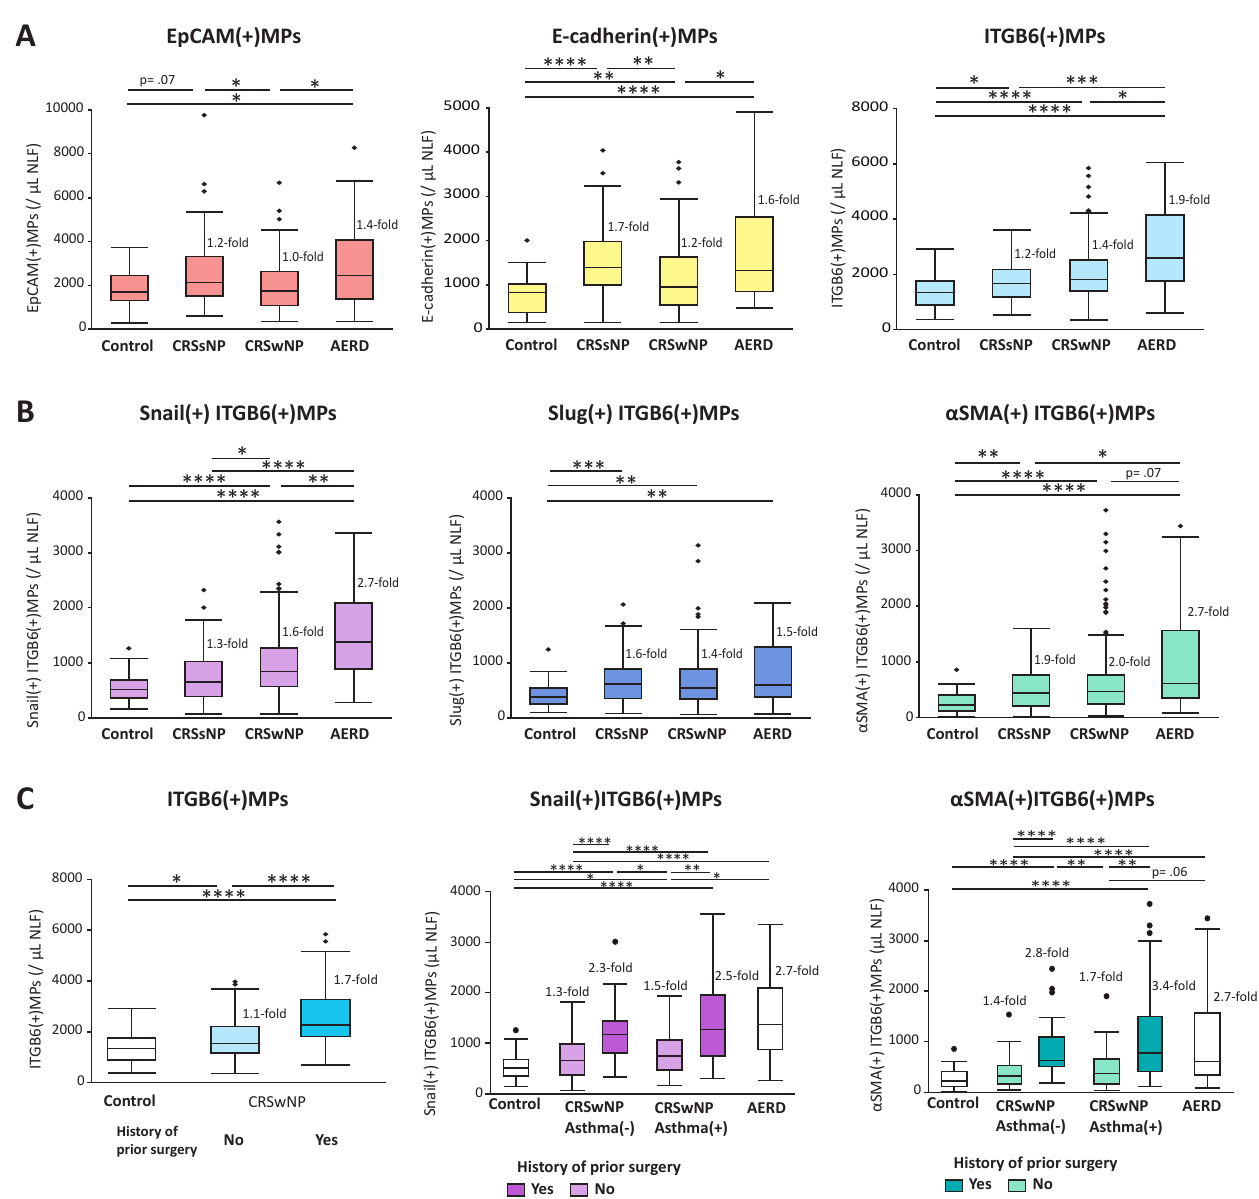
Figure 5. Comparisons of epithelial MP levels in NLFs. ( A ) Comparison of EpCAM(+)MPs, E-cadherin(+)MPs, and ITGB6(+)MPs among control, CRSsNP, CRSwNP, and AERD. ( B ) Comparisons of dual-positive EMT marker (Snail, Slug, or α SMA) ITGB6(+)MPs among control, CRSsNP, CRSwNP, and AERD. ( C ) Comparison of ITGB6(+)MPs between CRSwNP with history of prior surgery (cases undergoing surgery to treat polyp recurrence) vs. without prior surgery (primary surgical cases), and comparisons of Snail(+) ITGB6(+)MPs and α SMA(+) ITGB6(+)MPs between CRSwNP with asthma vs. without asthma (including those with history of prior surgery and those without prior surgery, as indicated). We enrolled cases with CRSwNP ( n = 196), CRSsNP ( n = 70), and AERD ( n = 31) who had endoscopic sinus surgery (ESS) at Northwestern Memorial Hospital. In addition, we also enrolled control cases ( n = 47) who underwent surgery other than ESS without sinus disease. NLFs were collected at the time of surgery, and MPs were measured using a BD FACS LSRII flow cytometer (BD Biosciences, Erembodegem, Belgium). *, p < 0.05; **, p < 0.01; ***, p < 0.001; ****, p < 0.0001; ##-fold, significantly higher by ##-fold vs. control. Adapted with permission from John Willey and Sons. Ltd., Allergy, Takahashi